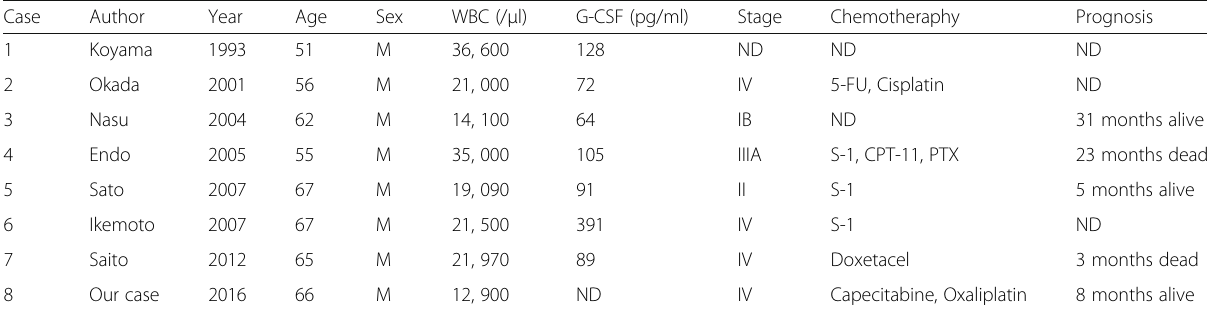
Table 1 Summary of the reported cases of granulocyte-colony stimulating factor-producing gastric adenosquamous cell carcinoma